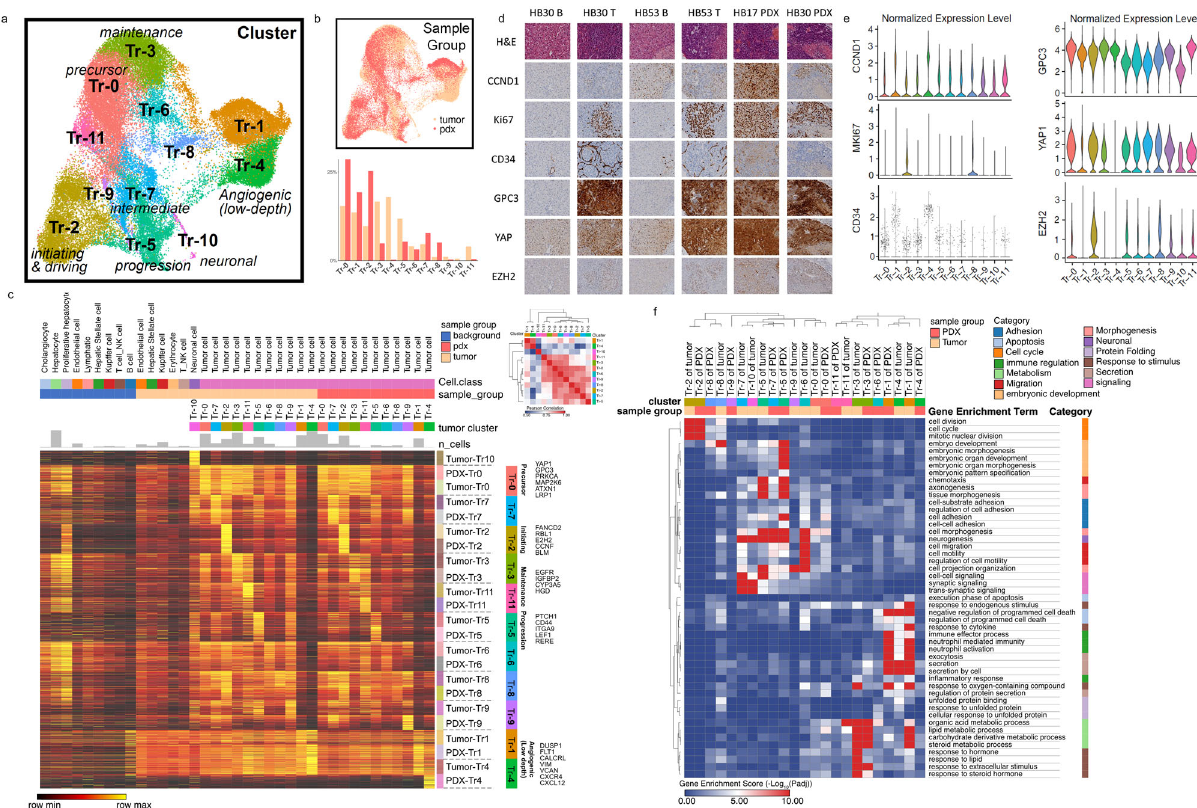
Fig. 5 Gene expression de fi nes initiating cell potential and other functional roles in tumor cell clusters. a The UMAP visualization showed the clusters found in the tumor cells from tumor and PDX after integration and reclustering. Cells in different states are labeled. Tr1 and Tr4 are clusters with relatively low sequencing depth. b UMAP visualization of sample-group distribution (Top) and percentages of clusters in each sample group (Bottom). c A heatmap was drawn for 200 most upregulated genes per tumor cluster in each sample group. Cell types in background liver and tumor microenvironment are shown as the reference. Normalized values were used for expression levels. Key signature genes in some clusters are shown on the right. Similarity matrix of tumor clusters was calculated with Pearson correlation based on a combined gene list from (c). Hierarchical clustering was applied for rows and columns. d IHC was conducted in B, T, and PDX samples from HB30, B and T from HB53, and PDX from HB17 to show localization of CCND1, KI67, CD34, GPC3, YAP, and EZH2 to differing regions of tumor (20X, scale bar 50 µ M). e Violin plots of gene expression for the corresponding genes in (d) are shown to show the expression patterns in each tumor cluster. Dots are only shown in the violin plot of CD34 due to its relatively sparse expression in the single-cell data. f A heatmap of gene set enrichment scores ( − log 10 Padj) of each cluster by ToppGene enrichment using genes in ( c ). Tumor-association enrichment terms in Gene Ontology (Biological Process) were selected and grouped into several categories. Hierarchical clustering was applied for rows and